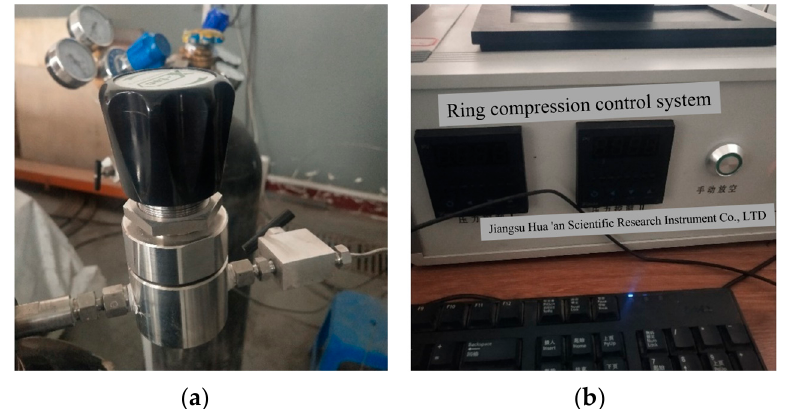
Figure 5. Axial compression loading system. ( a ) Confining pressure regulating valve; ( b ) Confining pressure controller.